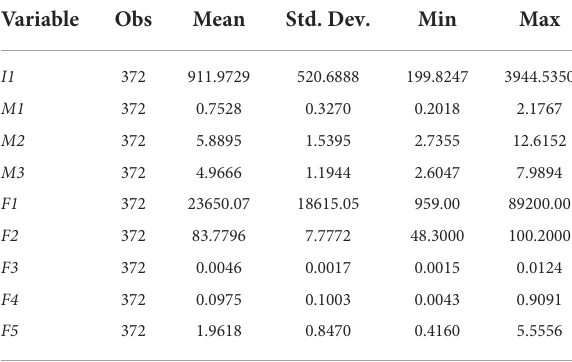
TABLE 2 Descriptive statistics of input-output indicators.